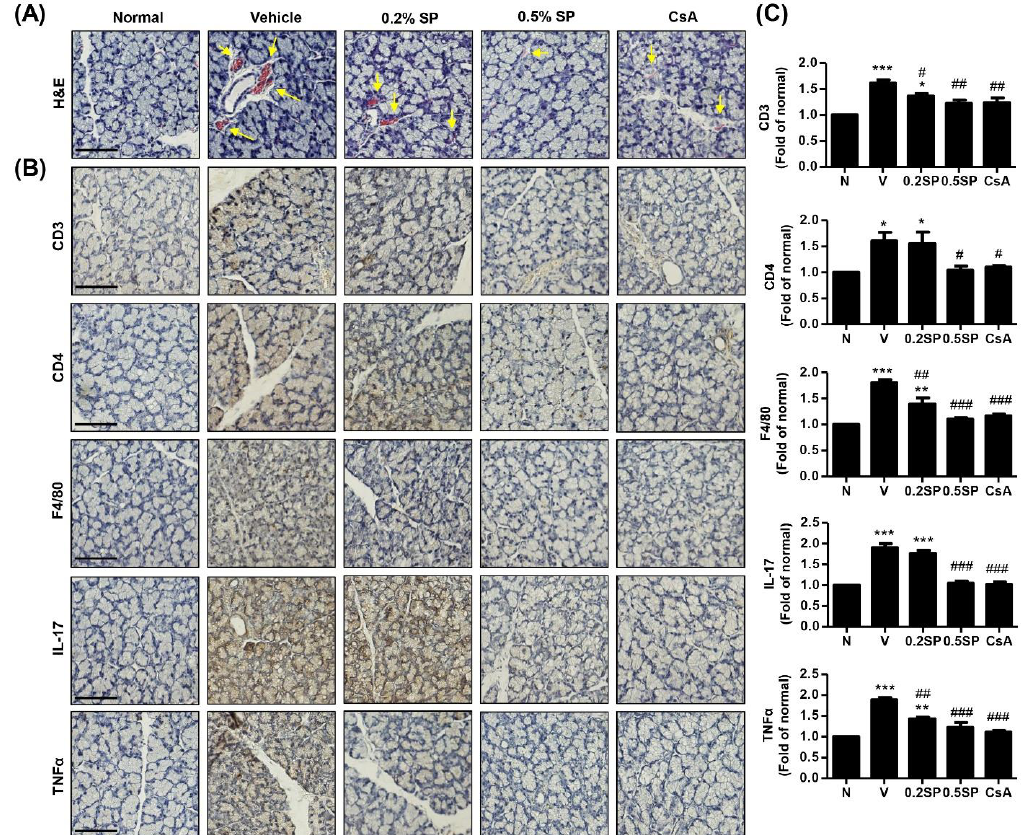
Figure 4. Effect of spermidine on inflammation of the lacrimal gland in a rat model of PM 2.5 -induced DED. ( A ) Representa- tive images of H&E staining in the lacrimal gland. Yellow arrows indicate neo-vessels. Scale bar; 50 µ m. ( B ) Representative images of immunohistochemical staining for CD3, CD4, F4/80, IL-17 and TNF-α, in lacrimal gland sections. Scale bar; 50 μm. ( C ) The stained area of the photograph was quantitative analyzed using ImageJ ® and calculated in terms of the fold of the normal. The data are expressed as the means ± standard deviation ( n = 3). * p < 0.05, ** p < 0.01 and *** p < 0.001 compared to normal group. # p < 0.05, ## p < 0.01 and ### p < 0.001 compared to the vehicle group.